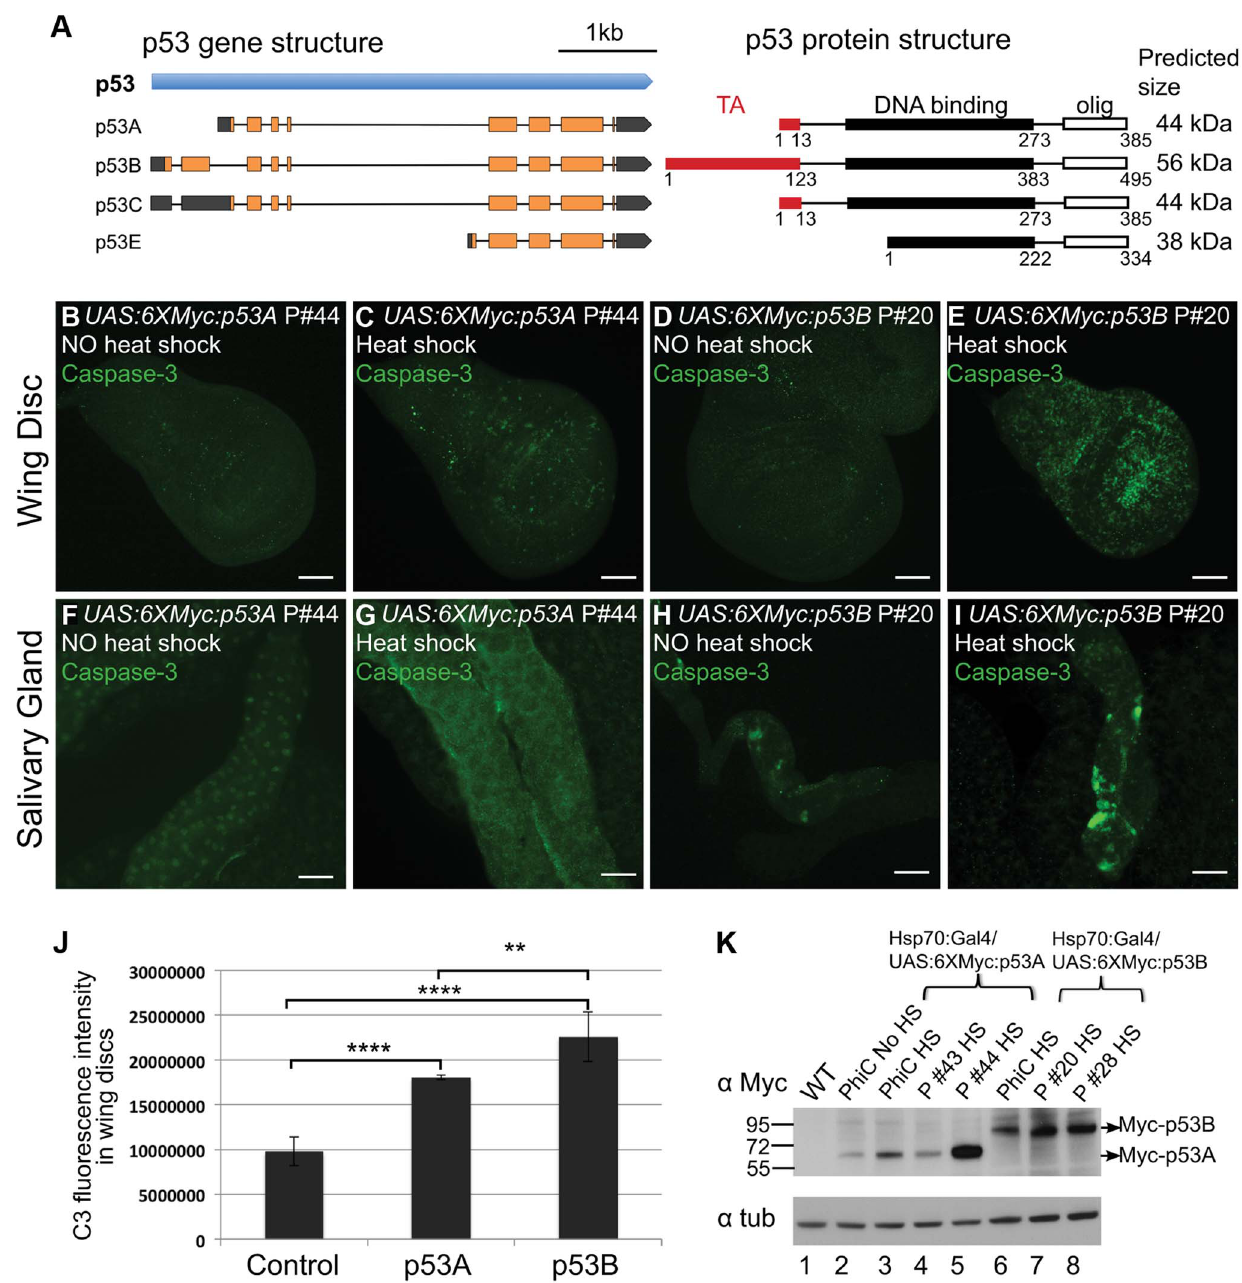
Figure 2. Over-expression of the p53B isoform, but not p53A, induces apoptosis in endocycling cells. (A) Left panel shows a map of the four predicted RNA transcripts for the Drosophila p53 gene based on cDNA and RNA-seq data annotated in Flybase. Exons are boxes, with predicted ORFs in orange, and 5 9 or 3 9 UTRs in gray. The right panel shows predicted protein isoform structures and sizes, with transactivation (TA) and DNA binding domains indicated by red and black boxes respectively. The protein domain predictions are adapted from Khoury and Bourdon (2010), which was based on protein alignment and needed further experimental confirmation [99]. (B–I) Activated Caspase-3 labeling in 3 rd instar larval wing discs (B–E) or salivary glands (F–I) after over-expression of UAS:6XMyc:p53A (C,G) or UAS:6XMyc:p53B (E,I) six hours after a 30 min heat pulse of hsp70:GAL4 or no heat shock controls (B, D, F, H). Scale bars are 100 microns. (J) Quantification of the fluorescence intensity of Caspase-3 (C3) staining in the larval wing discs. Error bars represent S.E.M. for n=4. ** p # 0.01, **** p # 0.0001. (K) Anti-Myc Western blot for Myc:p53 protein from adult wild type (WT) and different UAS:p53 P element (P) or PhiC31 (PhiC) transgenic lines six hours after a 30 min heat pulse of hsp70:GAL4 (HS), or no heat shock (No HS). Anti-alpha tubulin was used as a loading control. expression of these isoforms using Sgs3:GAL4 , which first apoptosis in salivary glands while p53A did not (Figure S4 A–B 9 ). becomes active in mid-3 rd instar larval salivary glands. Within Analysis of multiple transformed lines by immunofluorescence and hours after this induction, acute p53B expression strongly induced Western blotting showed that while transgene expression was